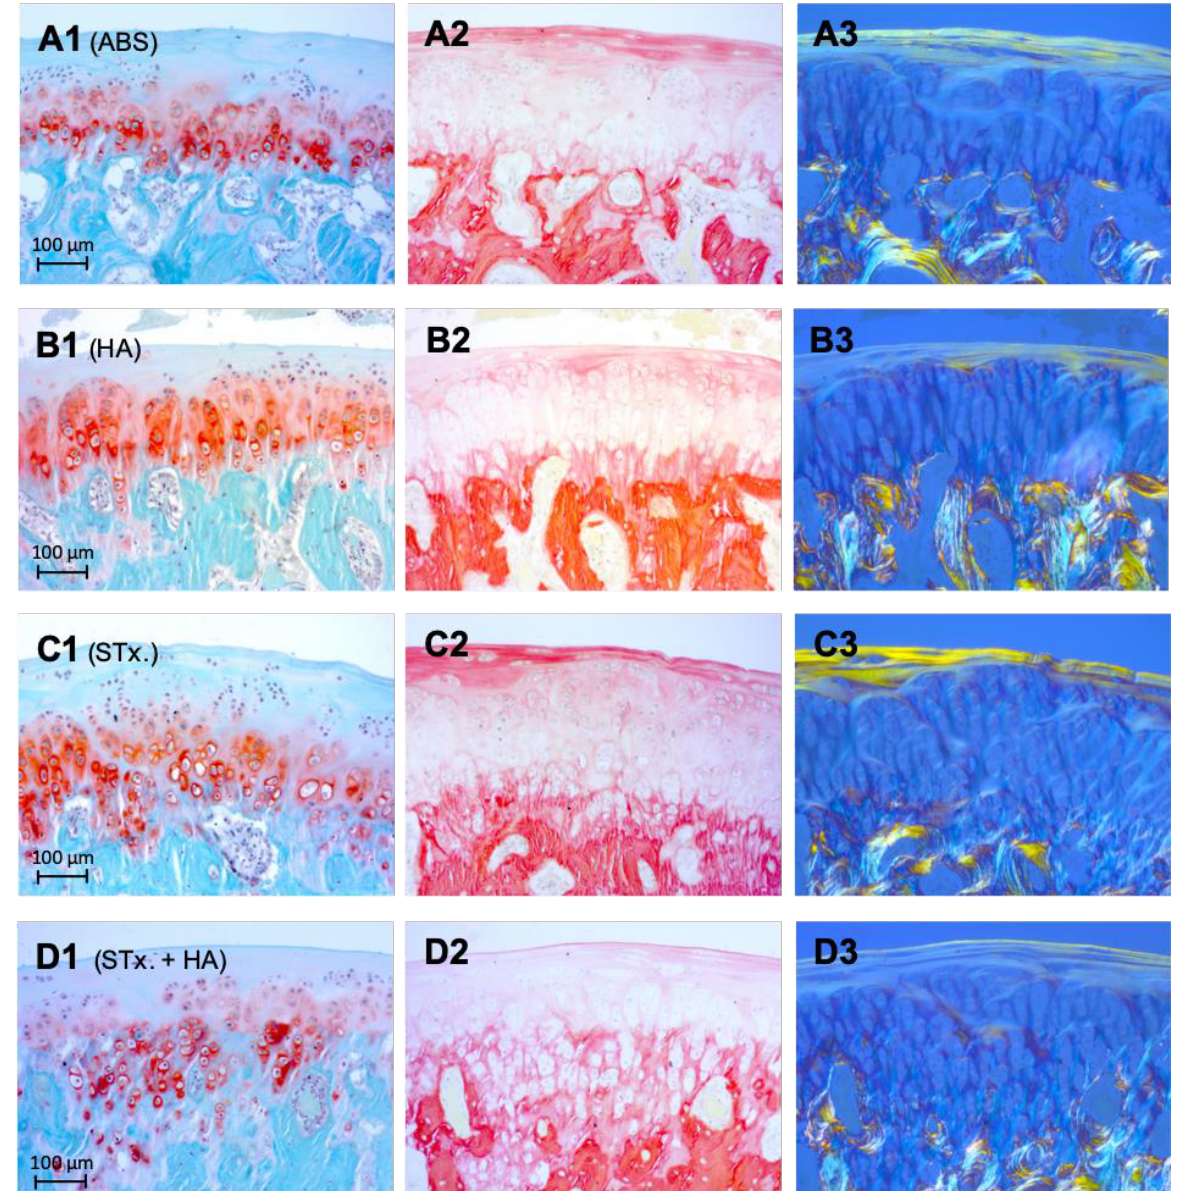
Figure 3. ( A – D ). Histological analysis 4 weeks after intra-articular injection therapy (1 = Safranin-O, 2 = Picrosirius red, 3 = Picrosirius red (polarized)). ( A1 – A3 ) representing group 1 (ABS), ( B1 – B3 ) group 2 (HA), ( C1 – C3 ) group 3 (STx.), and ( D1 – D3 ) group 4 (STx. + HA). Collagen I on cartilage surface could be visualized much better in group 3 (STx.) than in the other groups (Picrosirius red: red; Picrosirius red (polarized): yellow-orange), indicating a comparatively higher cartilage regeneration. A statistical significance analysis was not performed. Overall, no significant increased or decreased GAG accumulation could be detected in any of the groups using Safranin-O